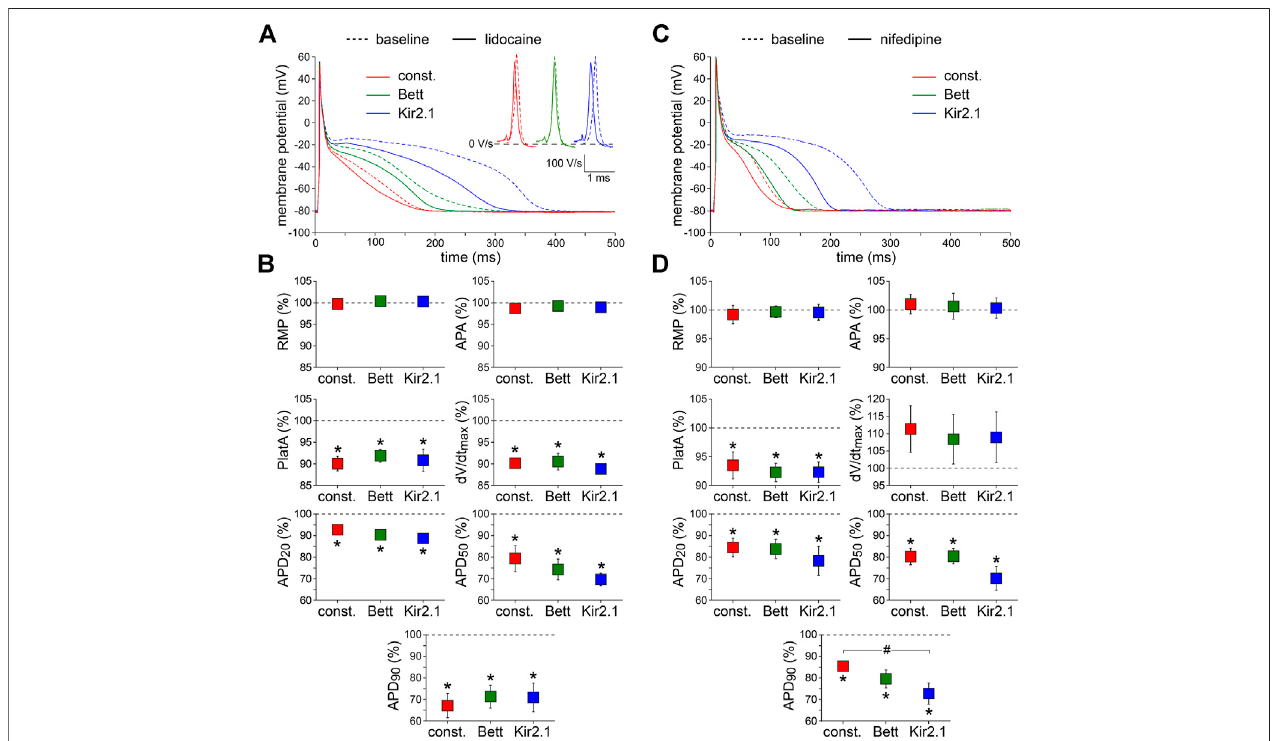
FIGURE3| EffectsofinwardcurrentblockadeonAPsmeasuredwithconstantandI K1 currentinjection. (A) TypicalAPsofoneatrialmyocyteinabsence(baseline) and presence of lidocaine to block the fast Na + current. Inset: fi rst derivatives of the AP upstrokes, re fl ecting the amplitude of the fast Na + current. (B) Average AP parametersmeasuredin fi vecellsinpresenceoflidocaine.APparametersarenormalizedtotheAPparametersmeasuredunderbaselineconditionsinthesamecell. (C) Typical APs of one atrial myocyte in absence (baseline) and presence of nifedipine to block the L-type Ca 2+ current. (D) Average AP parameters measured in six cells in presence of nifedipine. AP parameters are normalized to the AP parameters measured under baseline conditions in the same cell. * p < 0.05, drug vs. baseline (paired t -test); # p < 0.05, drug effects observed with constant current, Bett current, and Kir2.1 current (ANOVA with follow-up